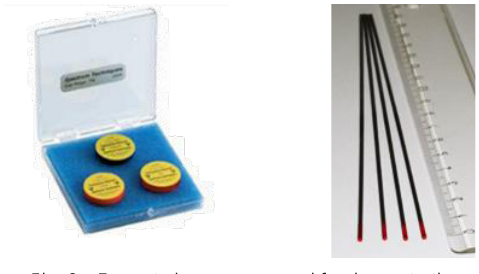
Fig. 8. Exempted sources are used for demonstrations.